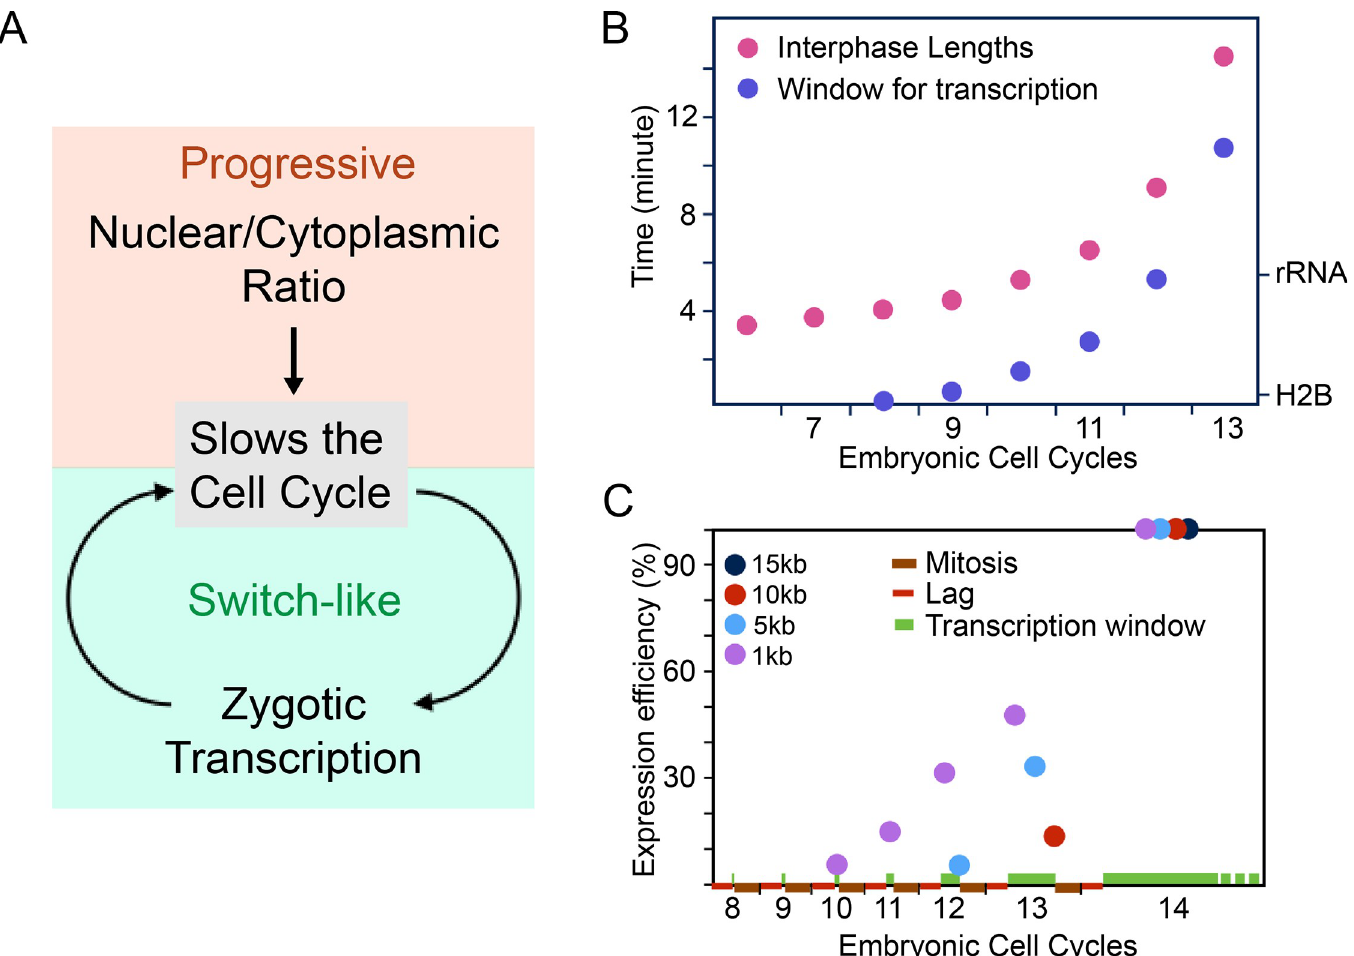
Fig 6. Timing transcriptional activation by relaxing interference from the cell cycle. (A) Proposed model in which the N/C input feeds into the MBT through its influence on the cell cycle. During the syncytial cycles, increasing N/C contributes to the increasing duration of the cell cycle. Interphase lengthening allows more time for gene expression and for completion of longer transcripts. Onset of expression of genes such as tribbles triggers further cell cycle slowing by engaging a switch-like shutoff of cyclin/Cdk1 by inhibitory phosphorylation that is enhanced by feedback through the expression of additional inhibitors of cell cycle progression. This switch in cyclin/ Cdk1 activity, in conjunction with dynamic transcriptional programs, transforms the regulatory architecture of the embryo. (B) The duration of interphase of pre-MBT cell cycles (red) with the time available to extend transcripts indicated (blue). The eclipse times for H2B and rRNA are given on the right. As expected, their transcription begins when the window of transcription exceeds the eclipse time. (C) Expression efficiency of primary transcripts of four different lengths as function of cell cycle progression. The larger transcription units have a later and more abrupt onset of productive expression. Note that this displays the earliest times that transcripts can be expressed, but their onset can be delayed by additional promoter-specific regulation. Except for cycle 14, which is simply set at 100%, the time-averaged percent expression was obtained by subtracting mitotic time, lag time, and eclipse time from the cell cycle length to determine the time during which complete transcripts can be produced and this is divided by total cell cycle time. This time average estimates a maximal relative efficiency of expression. Numerical data for panels B and C can be found in the file S1 Data.xlsx. MBT, mid-blastula transition; N/C, ratio of nuclei to cytoplasm.